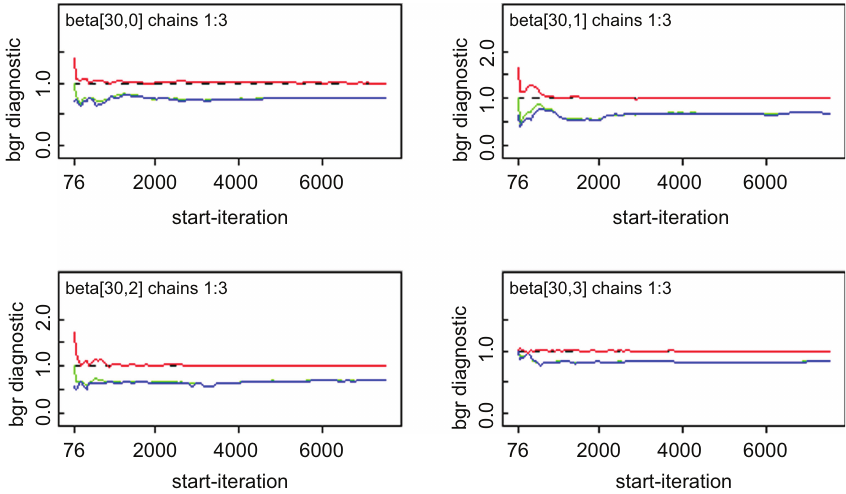
k through β 5 3 k at k